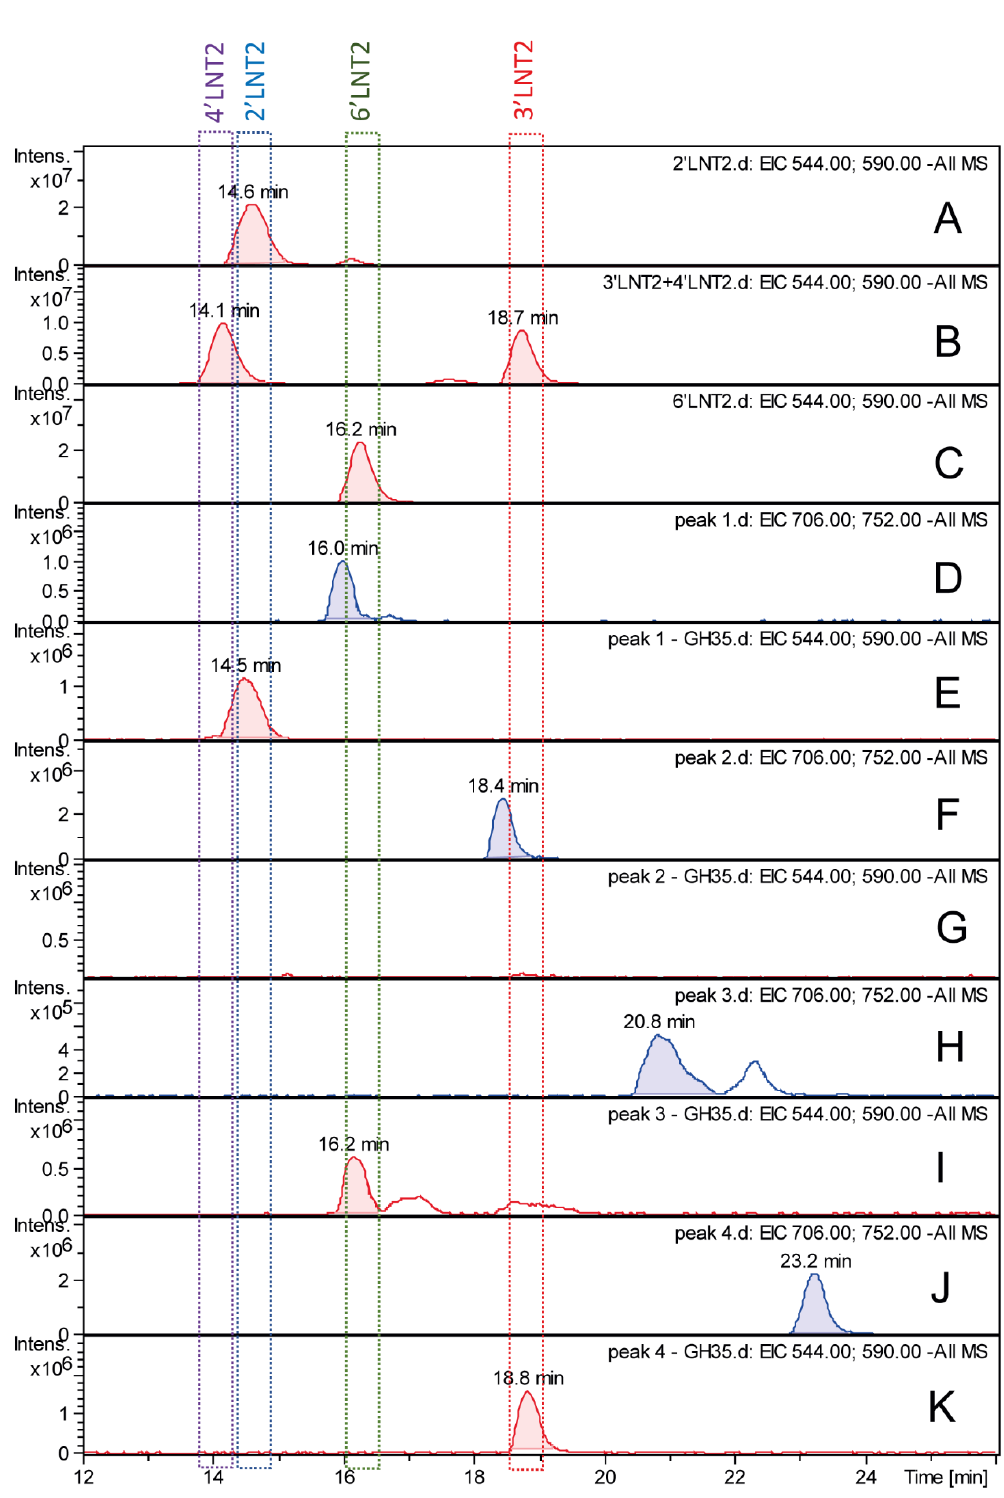
Figure 7. Retention time comparison of isolated isomers before and after GH35 β-galactosidase digestion. ( A – C ): Extracted ion chromatograms of 2′LNT2 (2′GlcNAc-Lac; ( A ), 14.6 min, blue box), 4′LNT2 + 3′LNT2 (4′GlcNAc-Lac + 3′GlcNAc-Lac; ( B ), 14.1 and 18.7 min, purple and red box), and 6′LNT2 (6′GlcNAc-Lac; ( C ), 16.2 green box) chemically synthesized standards. ( D – K ): extracted ion chromatograms of LNT isomers (blue chromatograms) in the isolated fractions and corresponding LNT2 isomers (red chromatograms) following GH35 β-galactosidase digestion.